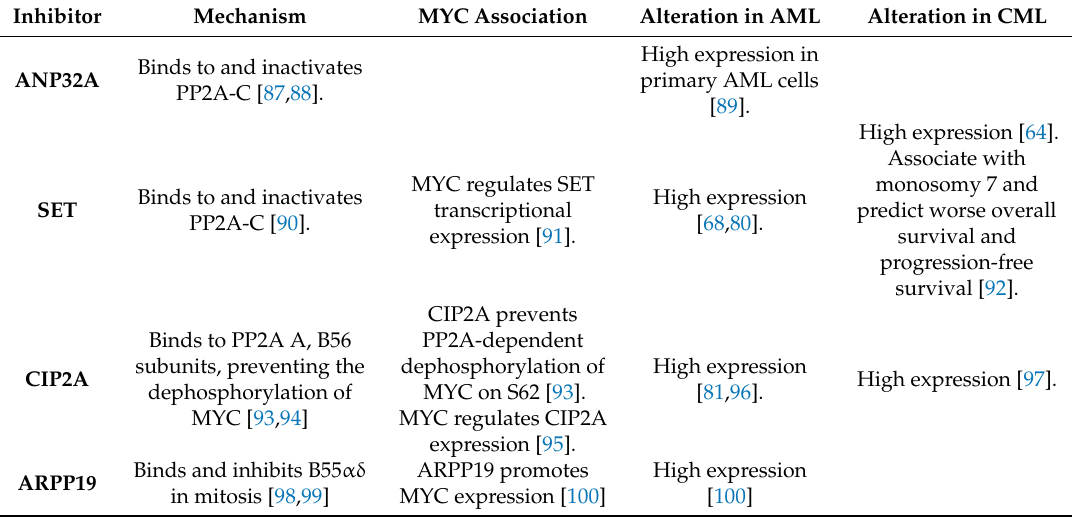
Figure 2. MYC / PP2A inhibitory network. MYC transcriptionally regulates SET and CIP2A. SET binds to the PP2A-C subunit, while CIP2A interacts with PP2A-B56 α subunit. Their increased expressions lead to PP2A inhibition in leukemia cells. SETBP1 is a SET binding protein overexpressed in myeloid leukemias that prevents SET cleavage. ARPP19 is another inhibitor of PP2A that has been recently reported to enhance the levels of CIP2A, SET, and MYC in AML. Table 2. PP2A endogenous inhibitors and reported alterations in AML and